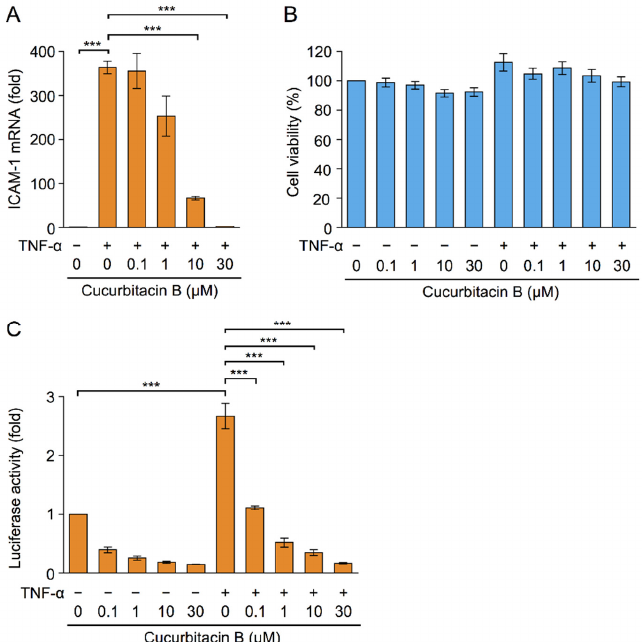
Figure 2. Cucurbitacin B inhibited TNF- α -induced ICAM-1 transcription. ( A , B ) A549 cells were pre- treated with or without cucurbitacin B for 1 h and were then treated with (+) or (−) TNF-α (2.5 ng/mL) for 3 h. ICAM-1 mRNA (fold) is shown as the mean ± S.E. of three independent experiments ( A ). Cell viability (%) is shown as the mean ± S.E. of four independent experiments ( B ). ( C ) A549 cells were transfected with plasmid vectors encoding the ICAM-1 promoter-driven firefly luciferase reporter and cytomegalovirus (CMV) promoter-driven Renilla luciferase reporter for 17 h. Trans- fected A549 cells were pretreated with or without cucurbitacin B for 1 h and were then treated with (+) or without (−) TNF-α (2.5 ng/mL) for 3 h. ICAM-1 promoter-driven luciferase activity was nor- malized to CMV promoter-driven luciferase activity. Luciferase activity (fold) is shown as the mean ± S.E. of three independent experiments. *** p < 0.001.